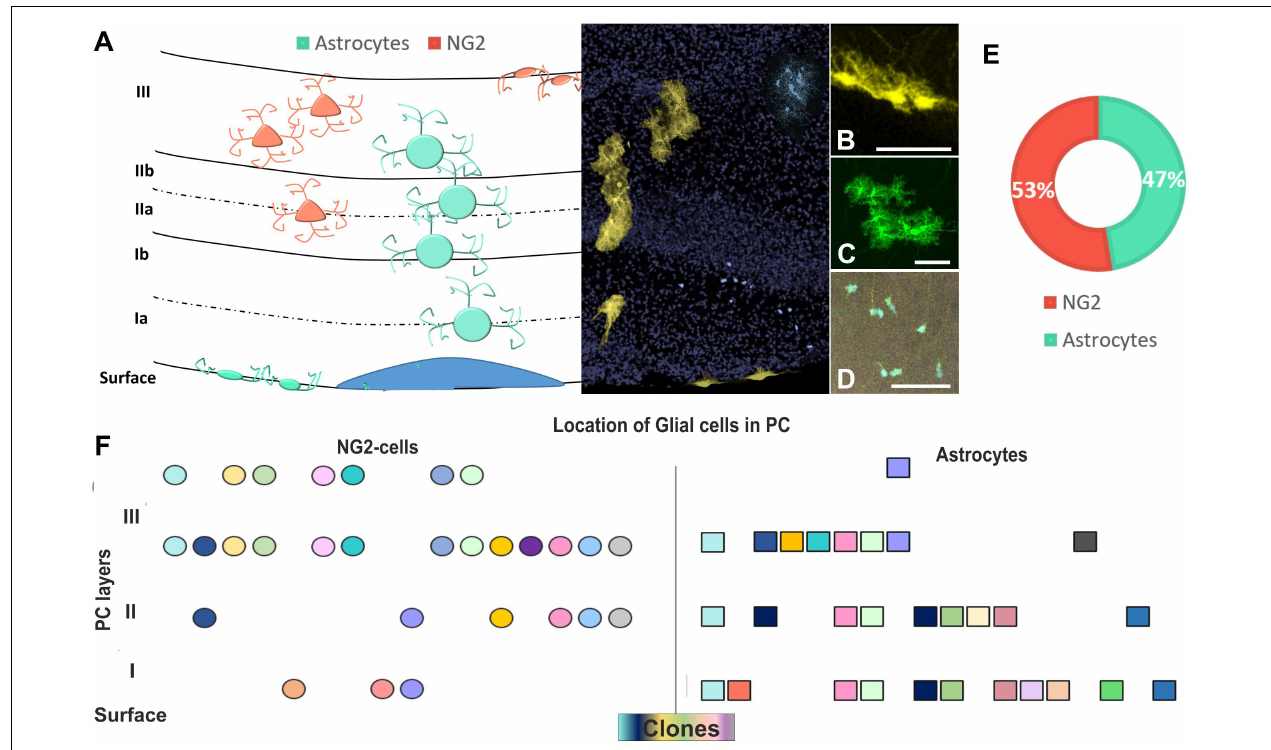
FIGURE 5 | Layer distribution of astrocytes and NG2 cells in the PC after targeting E12-progenitors. (A) Graphical scheme of glial cells location across the PC layers. Layer identification of the PC with DAPI (in gray) and UbC-StarTrack labeled cells shows the location of cells in the PC at P30. (B) Labeled cells with UbC-StarTrack along PC displayed discrete clusters of cells distributed from the pial surface (B) to lower cortical layers (C,D) , corresponding to pial astrocytes (B) , protoplasmic astrocytes (C) , and NG2-glia (D) . (E) The proportion of NG2 (53%) and astrocyte clones were similar (47%) in the three analyzed mice. (F) The location of clonally related cells in the PC shows clones of NG2 cells dispersed preferentially in layers II–III, while astrocyte clones dispersed along the different layers. NG2 cells are in soft red and astrocytes in blue/green. The NG2 clones are represented in circles and astrocytes are represented in squares. The different colors indicate each cluster of sibling cells. PC, piriform cortex; St, striatum; CC, corpus callosum. Scale bar: 50 µ